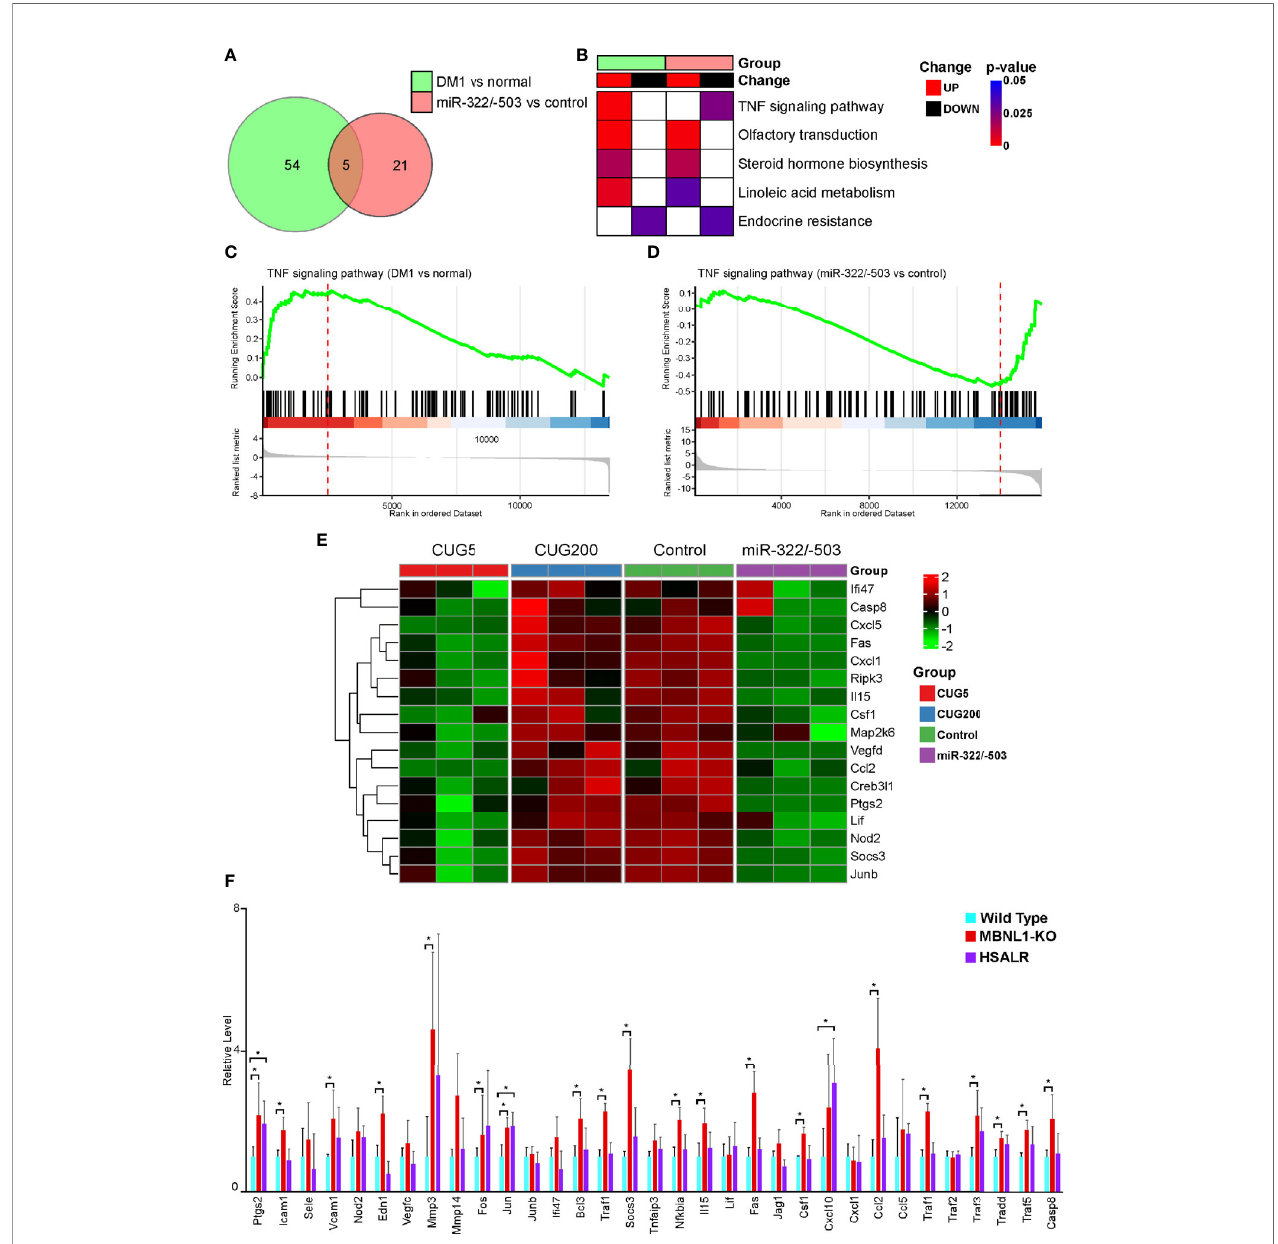
FIGURE 5 | The TNF signal was tightly associated with DM1 myogenesis. GSEA was performed on the RNA-seq datasets of DM1 versus normal myoblasts and miR-322/-503 overexpression versus control DM1 myoblasts to fi nd their signi fi cantly altered pathways, respectively. (A) Venn diagram of the pathways signi fi cantly altered in the two RNA-seq sets. (B) A heatmap showing the signi fi cance and change trends of the fi ve signaling pathways shared by the two RNA-seq sets. (C, D) . The GSEA curves of the TNF signaling pathway in the two RNA-seq sets. (E) A heatmap showing the relative levels of TNF signaling-related genes in the two RNA- seq sets. (F) The relative levels of TNF signaling-related genes in the quadriceps muscles of wild-type, MBNL1 knockout, and HSALR mice. DM1 vs normal, the RNA-seq dataset of DM1 versus normal myoblasts; miR-322/-503 vs control, the RNA-seq dataset of miR-322/-503 overexpression versus control DM1 myoblasts; CUG5, the normal group; CUG200, the DM1 group; Control, control empty vector stably transfected DM1 myoblasts; miR-322/-503, miR-322/-503 overexpressing DM1 myoblasts; n ≥ 3; *, p <